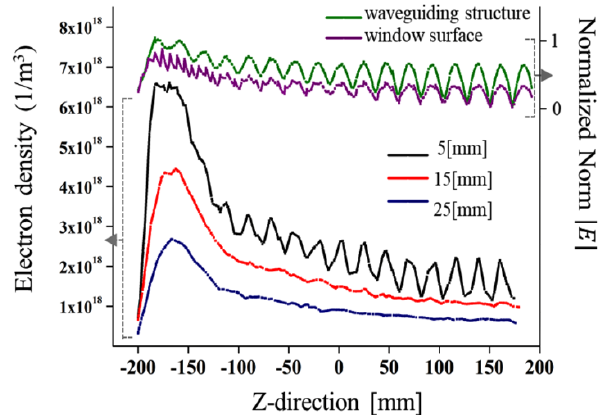
Figure 13. Attenuation of electron density along the axial direction (Z-axis) in the XZ plane (circular TE 11 waveguiding structure), distance (5 mm, 15 mm, 25 mm for black, red, and blue lines, respectively) from the window surface along the X-axis, normalized norm |𝐸| on the cut-surface of the cylindrical waveguiding structure (surface of the inner dielectric rod shown by the green line), and the window surface (purple line) are to compare the electron density distribution along the E-fied.